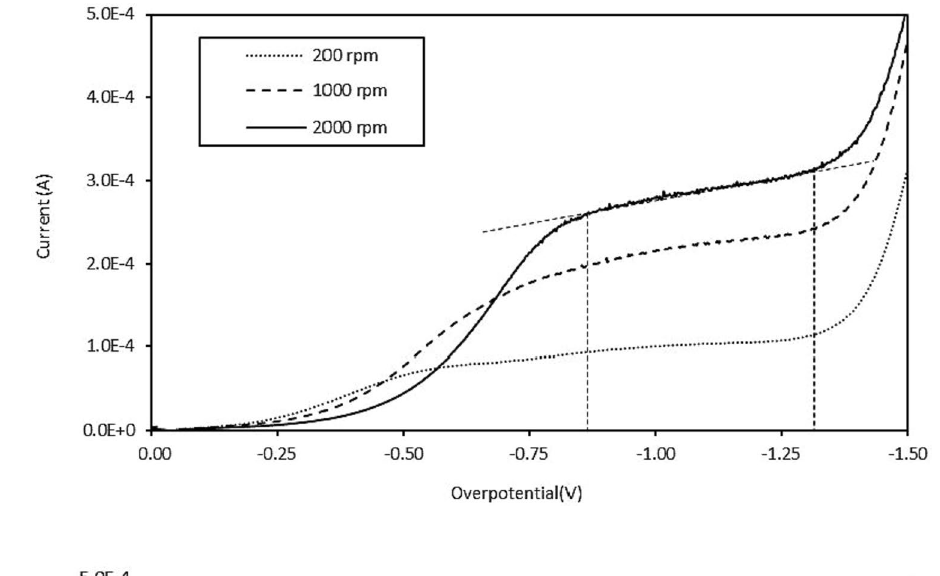
Fig. 9 IV curve for electrode of P-308-Mo